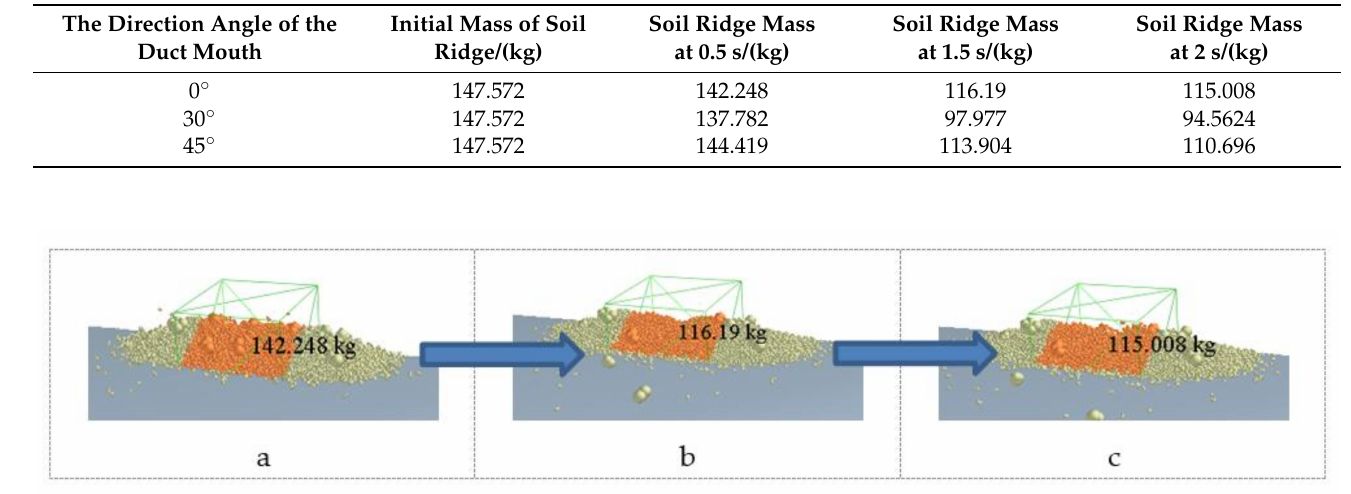
Table 5. The change of soil ridge quality with different direction angles of the duct mouth.